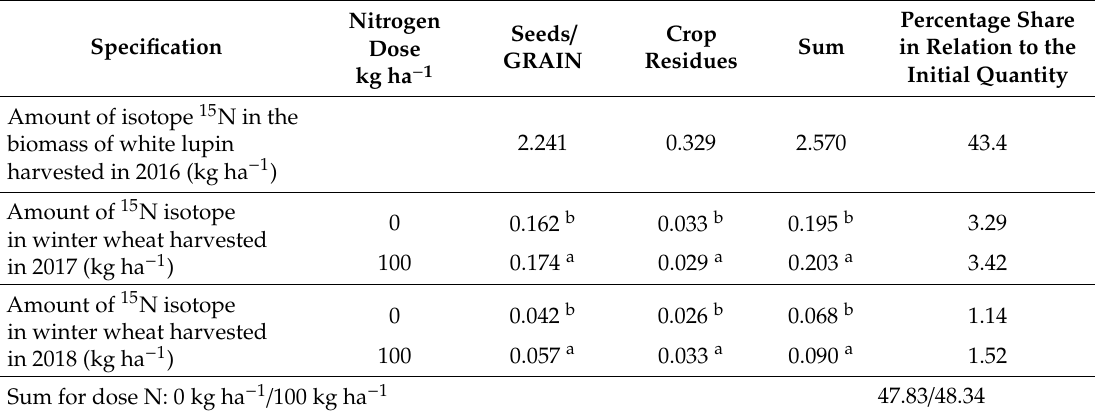
Table 7. Quantity (kg ha − 1 ) and percentage share of the 15 N isotope in the biomass of cultivated plants, in relation to the amount used in the form ( 15 NH 4 ) 2 SO 4